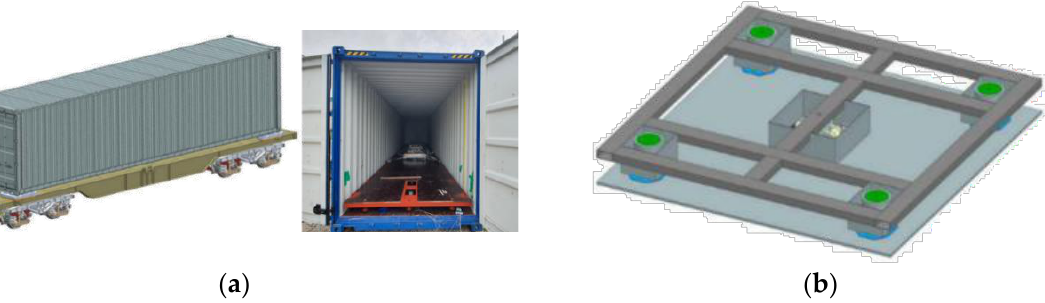
Figure 1. Cylindrical rubber spring: ( a ) wagon container; ( b ) internal module of cylindrical natural rubber spring installed with pallet.